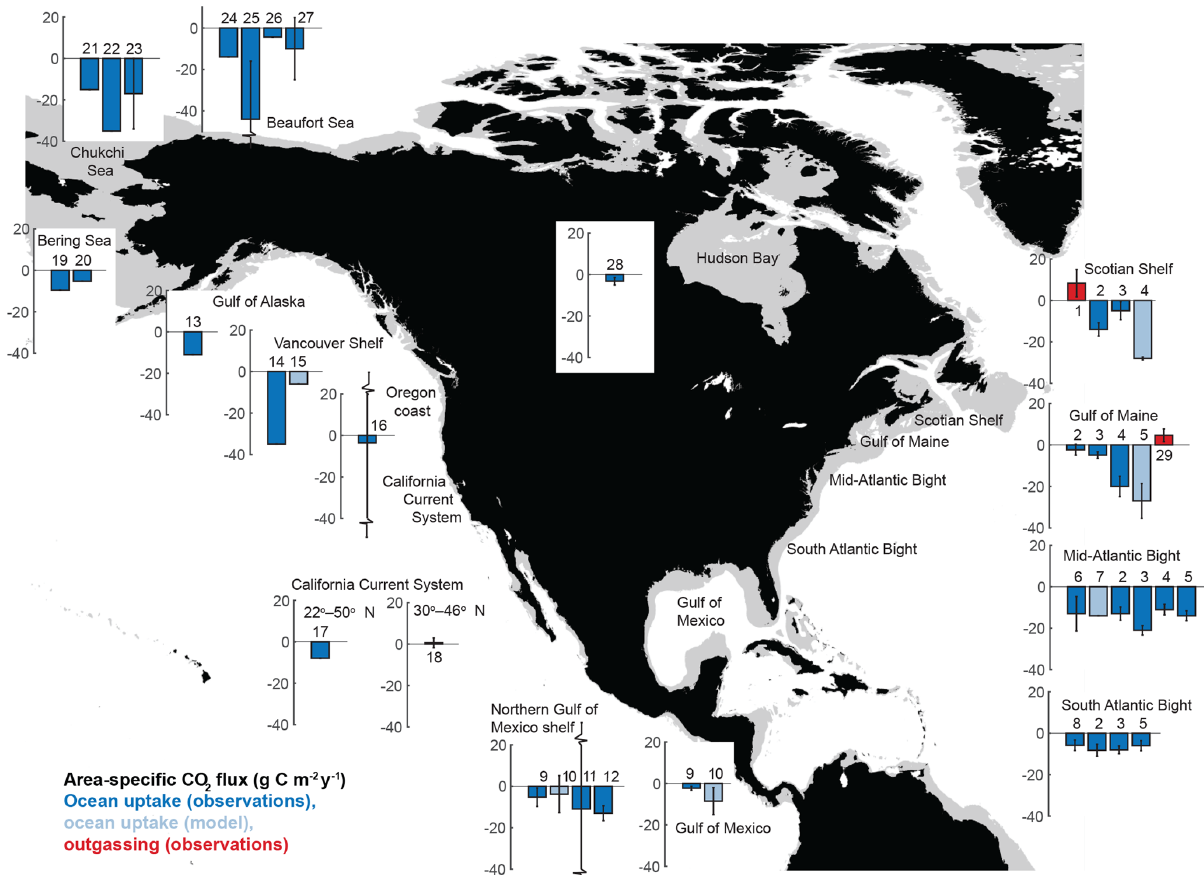
Figure 2. Observation- and model-based estimates of regional net air–sea CO 2 flux ingCm − 2 yr − 1 . Positive fluxes (red bars) indicate a flux to the atmosphere. Observation-based estimates are shown in red and dark blue. Model-based estimates are in light blue. Broken error bars are used where errors bars reach outside the range of the y axis. References: (1) Shadwick et al. (2010), (2) Signorini et al. (2013) using Ho et al. (2011) gas transfer parameterization, (3) satellite-based estimate from 2, (4) Fennel and Wilkin (2009), (5) Cahill et al. (2016), (6) DeGrandpre et al. (2002), (7) Fennel et al. (2008), (8) Jiang et al. (2008), (9) Robbins et al. (2014), (10) Z. Xue et al. (2016), (11) Huang et al. (2015), (12) Lohrenz et al. (2018), (13) Evans and Mathis (2013), (14) Evans et al. (2012), (15) Ianson and Allen (2002), (16) Evans et al. (2011), (17) Hales et al. (2012), (18) Turi et al. (2014), (19) Cross et al. (2014b), (20) Takahashi et al. (2009), (21) Evans et al. (2015b), (22) Gao et al. (2012), (23) Yasunaka et al. (2016), (24) Shadwick et al. (2011), (25) Else et al. (2013), (26) Evans et al. (2015b), (27) Mucci et al. (2010), (28) Else et al. (2008), (29) Vandemark et al. (2011). The flux estimates are also reported in Table S1 in the